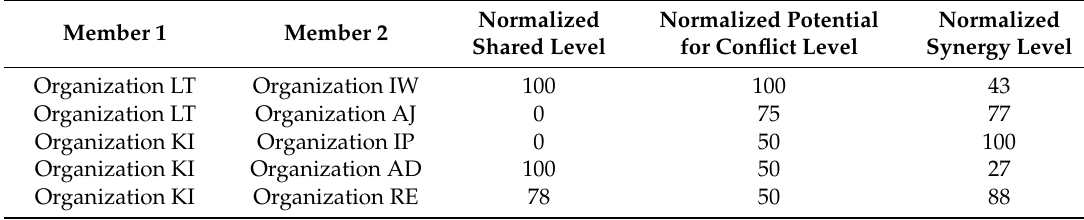
Table 9. Partial results from VBE Members vs Alignment